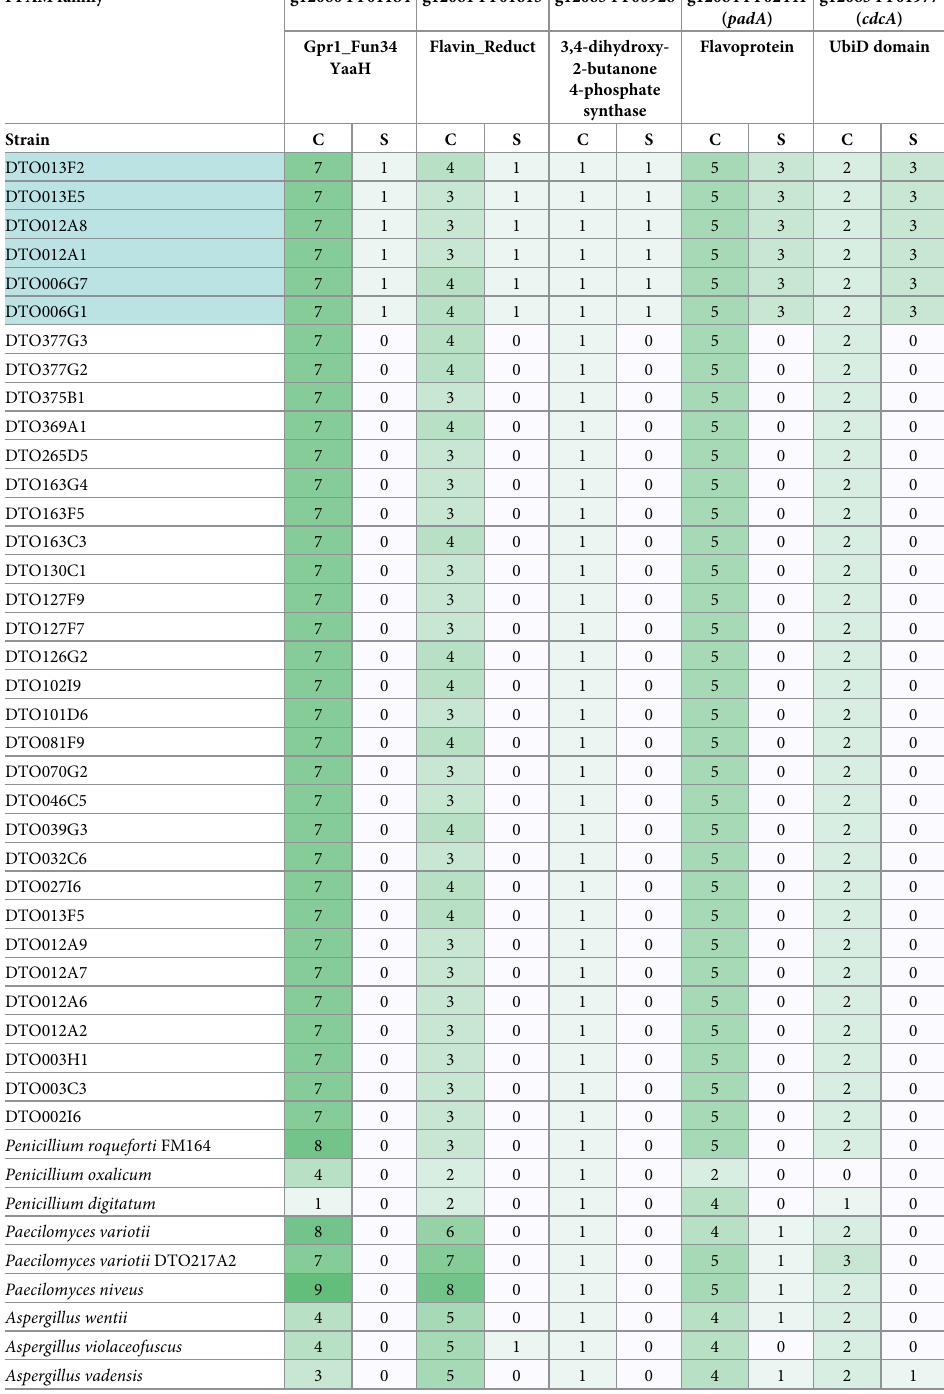
Table 4. Number of genes containing PFAM domains corresponding to g12060, g12061 and g12063-g12065 (PF01184, PF01613, PF00926, PF02441, PF01977) based on phylogenetic trees constructed with their respective PFAM domains. Top six strains are R-type P . roqueforti strains containing the SORBUS cluster. C (CORE) indicates if the domains aligned closely to the PFAMs not unique for the SORBUS cluster or did not align to P . roqueforti , S (SOR- BUS) indicates the number of PFAM domains which aligned closely to PFAMs originated from